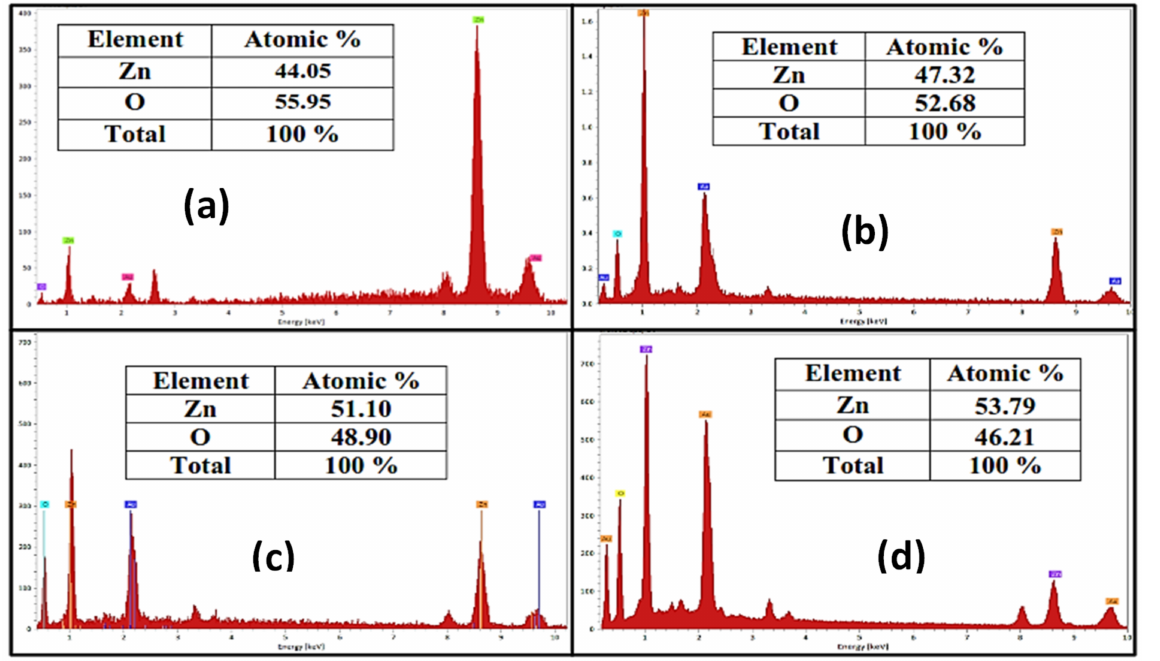
Figure 6. The EDX analysis of ZnO nanoparticles synthesized by using a green method and the leaf extract of the thyme plant at different calcination temperatures: ( a ) 150 ◦ C, ( b ) 250 ◦ C, ( c ) 350 ◦ C, and ( d ) 450 ◦